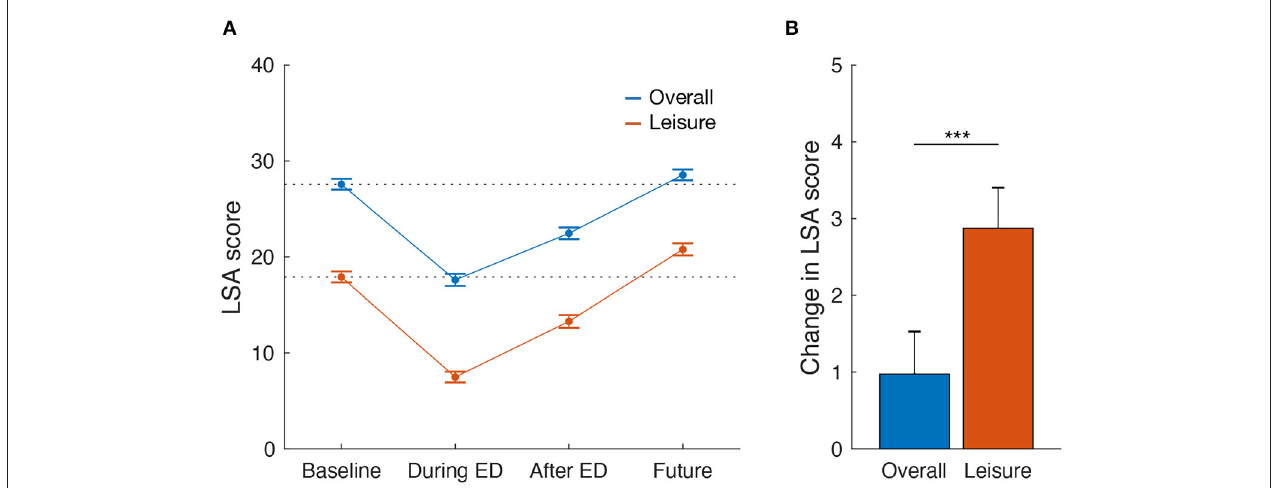
FIGURE 2 | Impacts of mobility restriction due to the COVID-19 pandemic on going-out activities in Japan. Going-out activities were assessed with the LSA score in four different time periods (A) : before the spread of infection (Baseline), during the ED and after the ED to refrain from unnecessary going-out activities, and in the future after the end of the pandemic (Future). LSA score increases in the future relative to the baseline period were significantly larger for leisure purposes, compared with overall purposes (B) . Error bars represent 95% confidence intervals. Dotted lines indicate LSA scores in the baseline period. *** P <